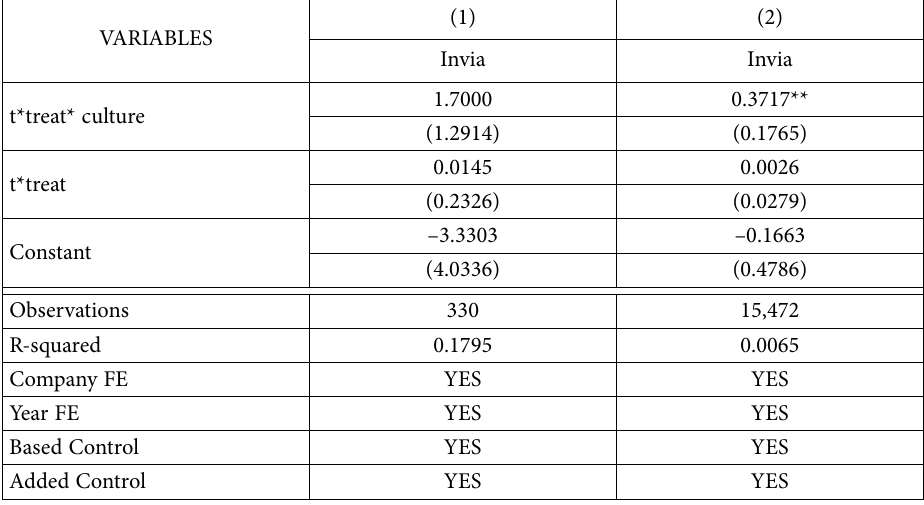
Table 7. Differences in information